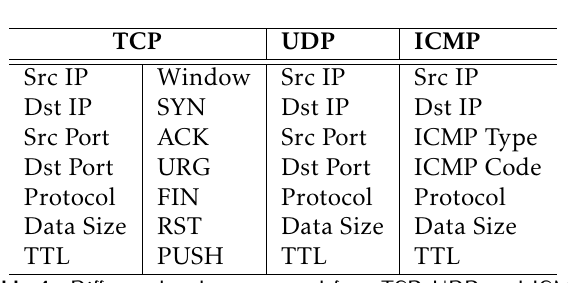
Table 1. Different headers extracted from TCP, UDP, and ICMP packets